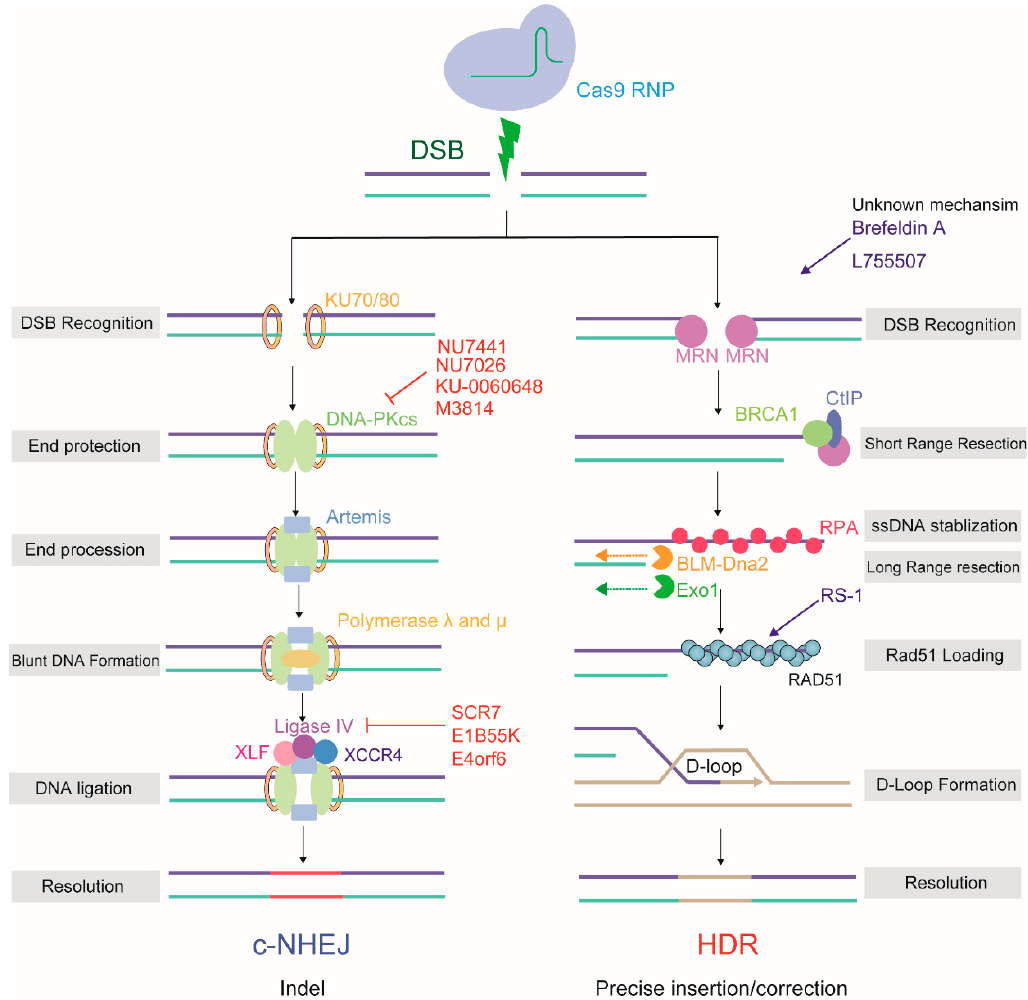
Figure 2. The mechanism and outcome of two major repair pathways: NHEJ and HDR, used by CRISPR/Cas9 induced-DSB in mammalian cells. NHEJ inhibitors are labeled in red, HDR activators are labeled in blue.NU7441, KU-0060648 and NU7026 suppress the DNA-PKcs; SCR7, E1B55K and E4orf6 suppress the ligase IV; RS-1 boosts RAD51; Brefeldin and AL755507 acts with unknown mechanism .